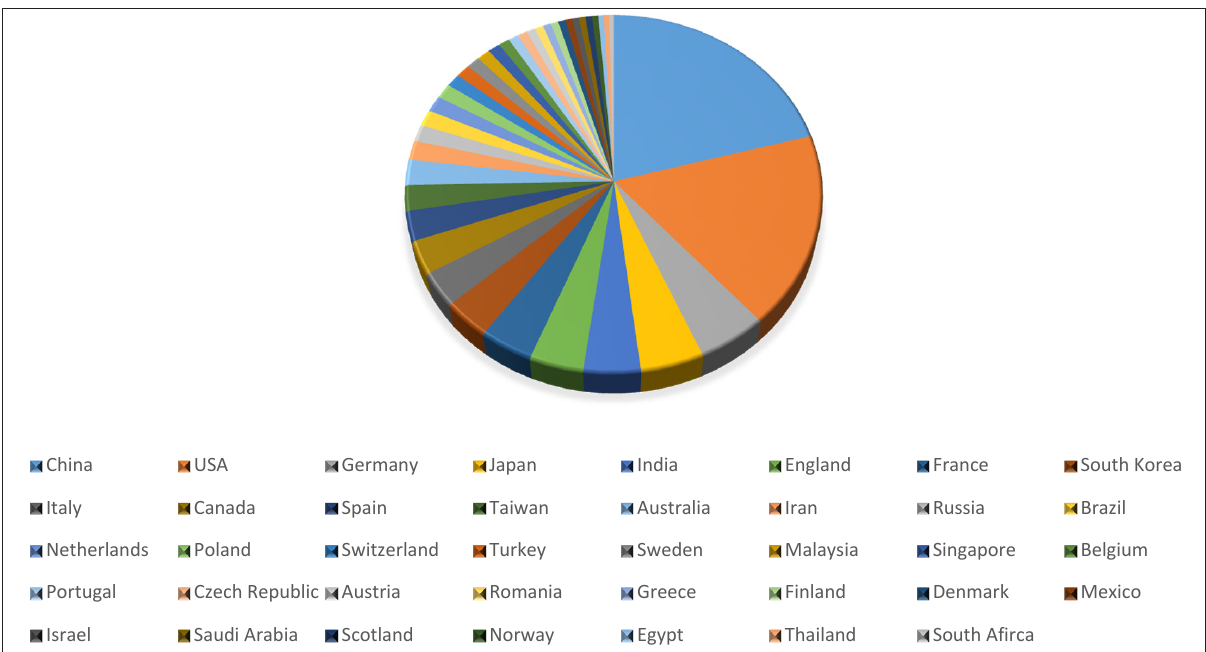
Table 1: Research performance of South Africa per discipline, 1995–2016